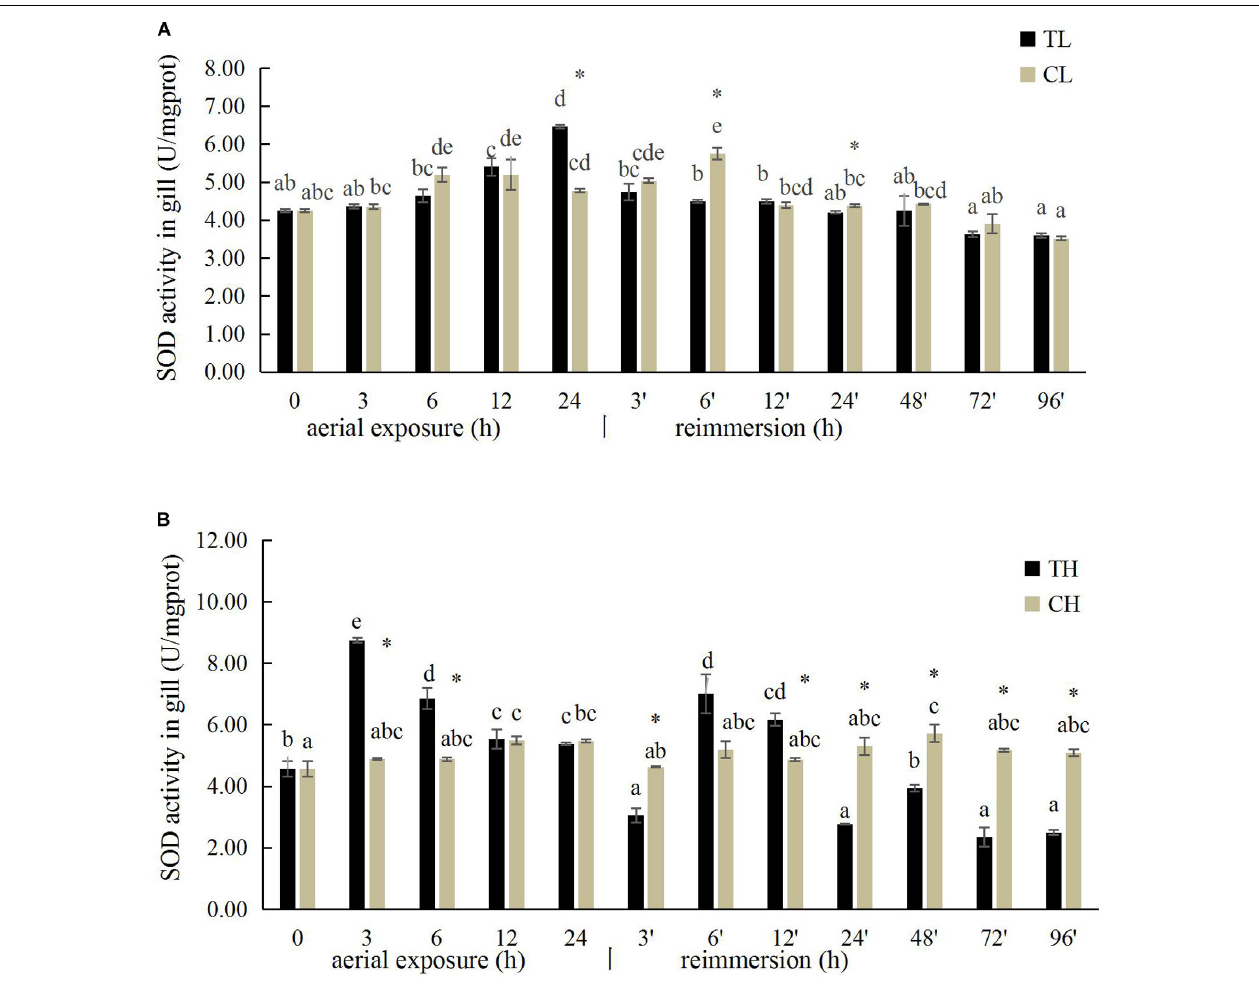
FIGURE 3 | Effects of aerial exposure on superoxide dismutase (SOD) in gill of R. philippinarum under low temperature (A) and high temperature (B)